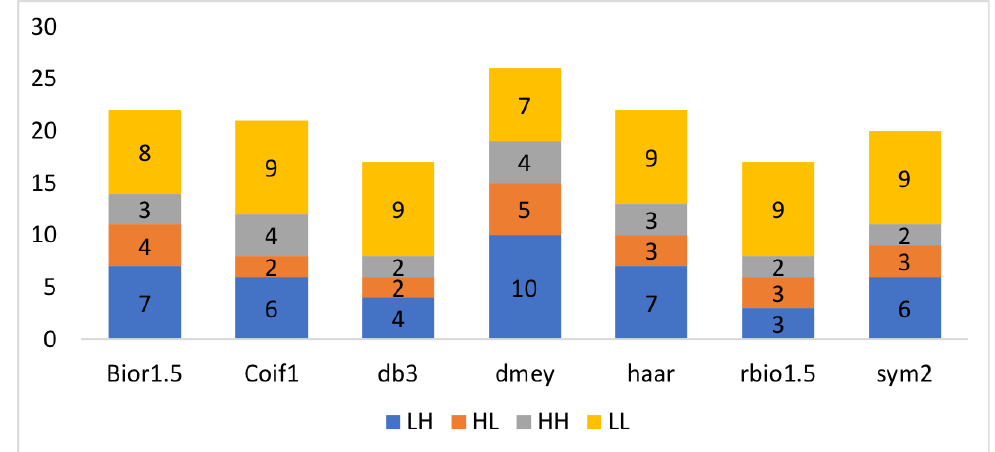
Figure 2. Upper : Selected features after near-zero variance analysis (in blue), correlation analysis (in orange), and statistical analysis (in gray), respectively. Lower : Selected features considering each wavelet decomposition.